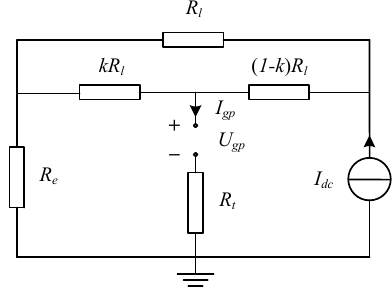
Figure 10. Equivalent circuit of single line grounding fault on electrode line system.